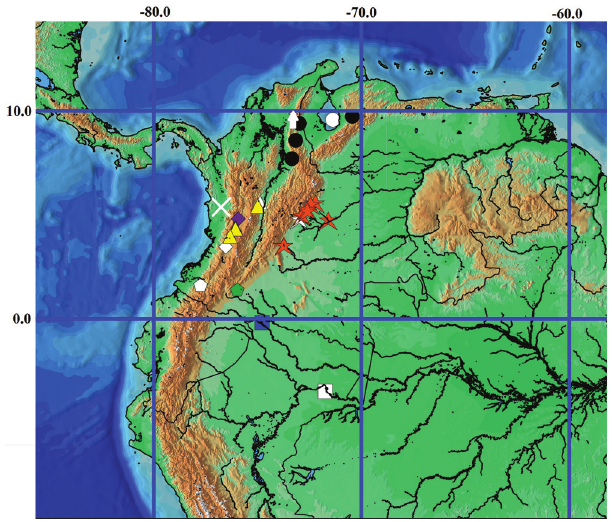
Fig. 2. Distribution of Parodon species in Colombia. Parodon apolinari (star); P. buckleyi (square); P. caliensis (diamond); P. pongoensis (pentagon); P. suborbitalis (circle); P. alfonsoi (arrow up); P. magdalenensis (triangle); P. atratoensis (X). Each symbol may represent more than one locality. Open symbols represents type locality of each species.